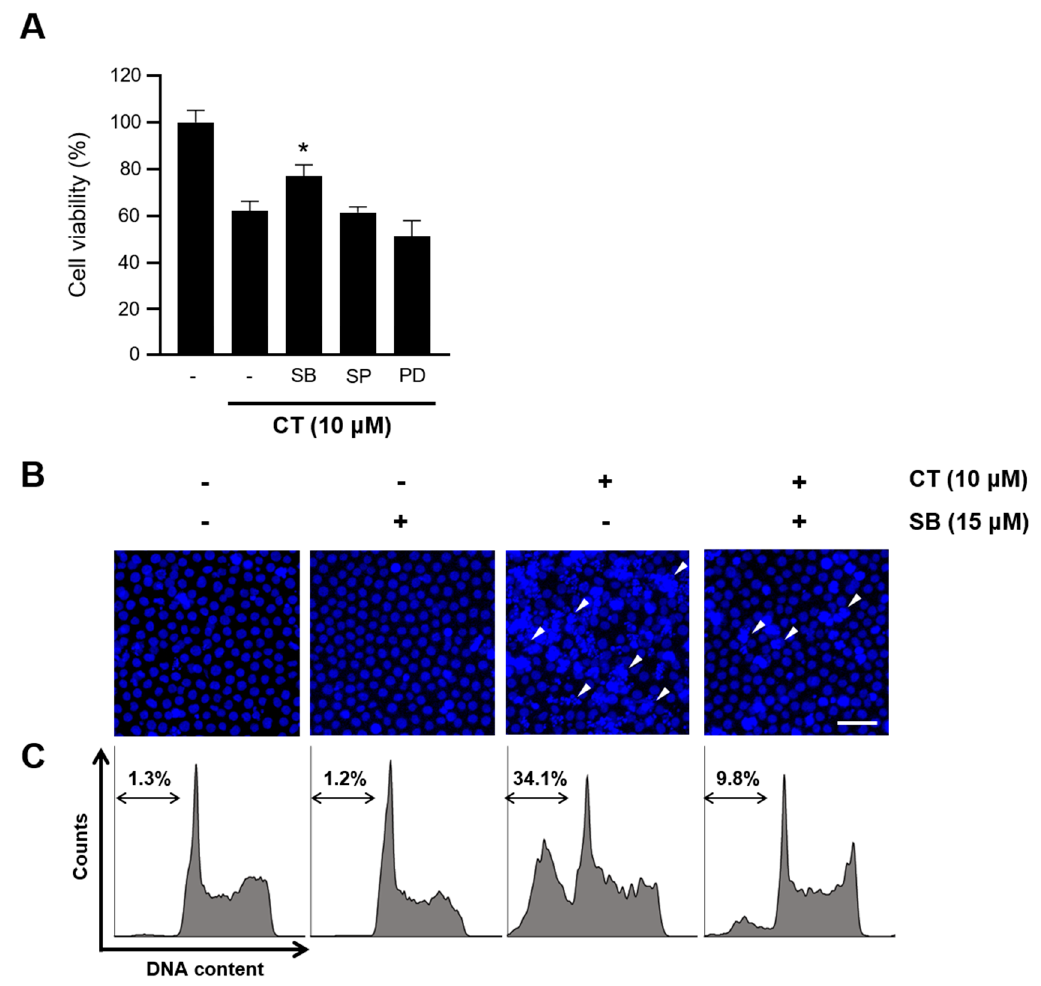
Figure 5. Recovered viability following the inhibition of p38 in CT-treated HL-60 cells. ( A ) MTT assay showing the cytotoxic effects of the CT treatment (10 μ M) for 24 h, followed by treatment with MAPK inhibitors for 2 h in HL-60 cells. SB: SB203580 (15 μ M), SP: SP600125 (5 μ M), and PD: PD98059 (10 μ M). * indicates p < 0.05 calculated by one-way ANOVA. ( B ) Confocal microscopic images showing nuclear staining with Hoechst 33342 and ( C ) flow cytometry using PI for measuring HL-60 cells in the sub-G 1 stage following cotreatment with SB203580 (SB) and CT. White arrowheads in the images indicate apoptotic bodies. Scale bar indicates 100 μ m. Double-sided arrows in flow cytometry data represent the area of the sub-G 1 stage.